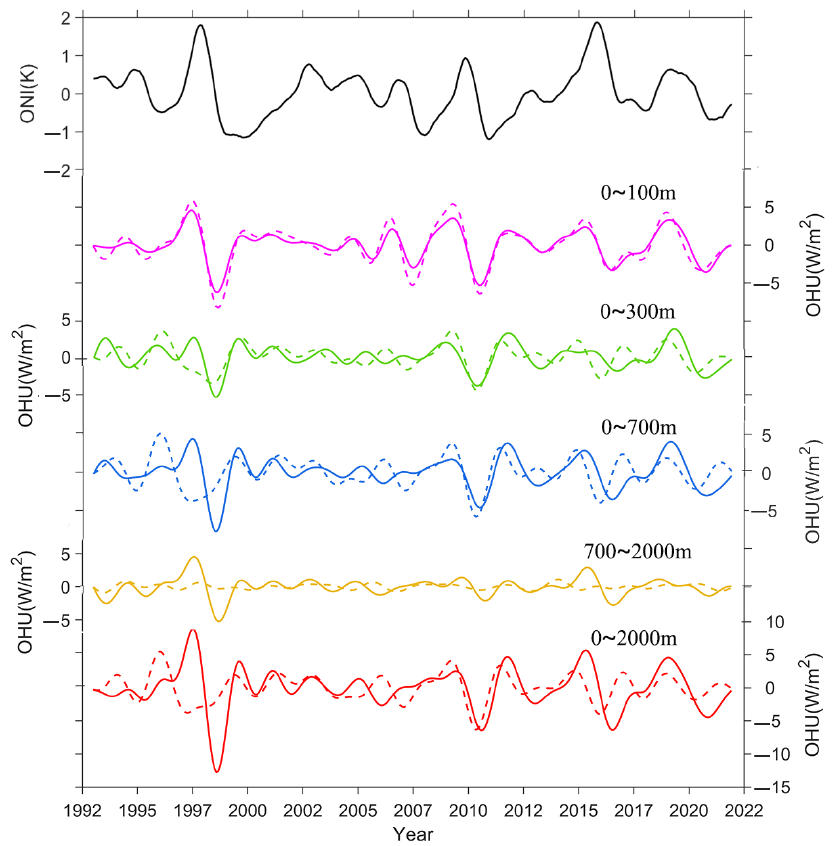
Figure 9. Time series of ONI and OHU from the OPEN (solid line) and IAP (dashed line) datasets. It is the same as Figure 7 except with OHU calculated using the equatorial 20° S – 20° N regional OHC.